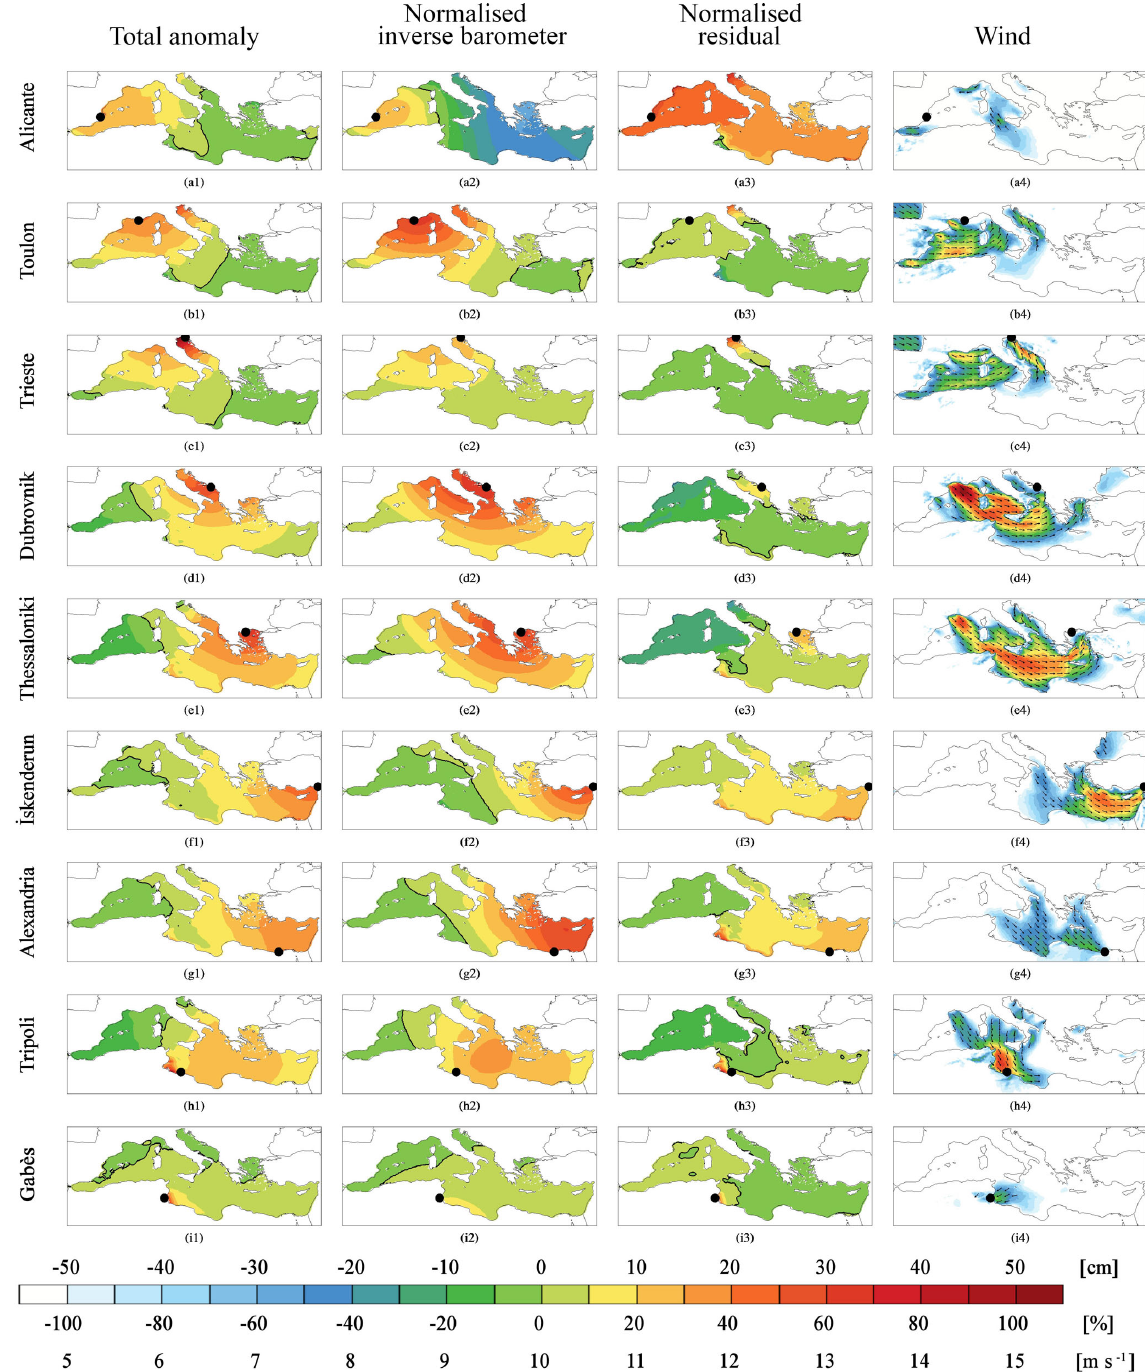
Figure 12. Composites of sea level anomalies and wind fields at the time of positive SLAs at the nine stations considered in this study: Alicante, Toulon, Trieste, Dubrovnik, Thessaloniki, ˙Iskenderun, Alexandria, Tripoli, Gabès (from top to bottom in this order). The first column reports the total anomaly (cm, upper annotation along the colour bar), the second column reports the contribution due to the inverse barometer effect and the third column reports the residual. Values in the second and third column are normalised with the maxima of the total SLA in the first column (%, first line of annotation below the colour bar). The thick black line denotes the zero level contour. The fourth column shows the wind field (ms − 1 , lowest annotation below the colour bar, values below 5ms − 1 are masked). Arrows that show the wind direction are drawn every 1.25 ◦ and only for values larger than 7.5ms − 1